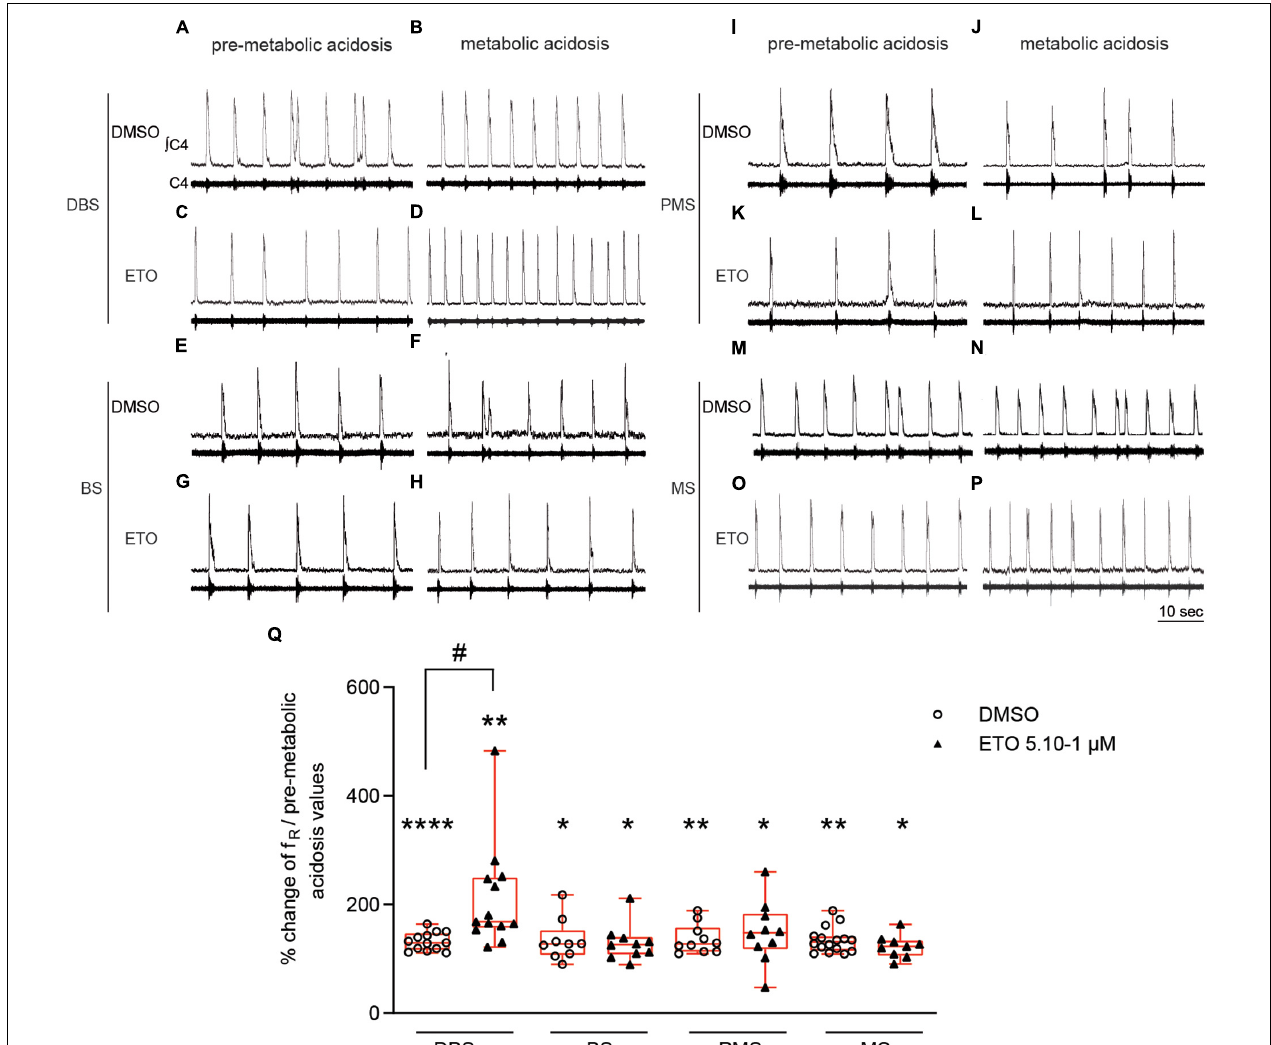
FIGURE 2 | Strengthening of respiratory response to prolonged metabolic acidosis by etonogestrel depends on the presence of diencephalon. (A–P) Representative traces illustrating respiratory C4 activity recorded in DBS (A–D) , BS (E–H) , PMS (I–L) , and MS (M–P) preparations, during condition of pre-metabolic acidosis under DMSO (A,E,I,M) or ETO (C,G,K,O) exposure and during condition of prolonged metabolic acidosis under DMSO (B,F,J,N) or ETO (D,H,L,P) exposure. (Q) Column scatter graph with a superimposed box and whisker plot (median [Q1;Q3]) showing percentage of change of f R at 25–30 min of metabolic acidosis under conditions of prolonged metabolic acidosis in the presence of either DMSO or ETO on DBS ( n = 13 and n = 13, respectively), BS ( n = 9 and n = 10, respectively), PMS ( n = 10 and n = 10, respectively), and MS ( n = 16 and n = 9, respectively) preparations. ∗ Indicates a significant intragroup change (one-sample t test) in f R relative to the values obtained just prior placing under conditions of metabolic acidosis. #Indicates a significant difference (one-way ANOVA followed by Bonferroni’s multiple comparison test) between groups. ∗ p < 0.05, ∗∗ p < 0.01, ∗∗∗∗ p < 0.0001, # p < 0.05. R C4: integrated activity of the C4 ventral nerve root; C4: electrical activity of the C4 ventral nerve root; ETO: etonogestrel, DBS: diencephalon-brainstem-spinal cord preparation, BS: brainstem-spinal cord preparation, PMS: ponto-medullary-spinal cord preparation, MS: medullary-spinal cord preparation.